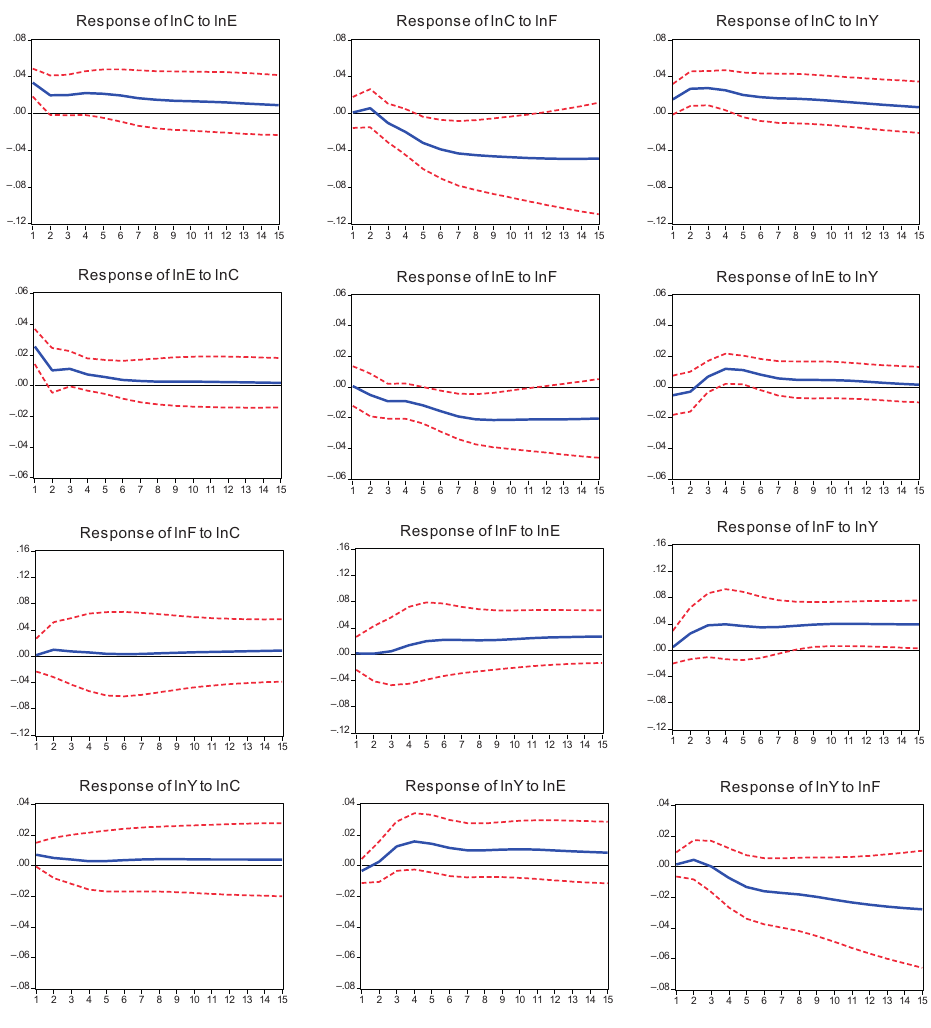
Fig. 3. Impulse response